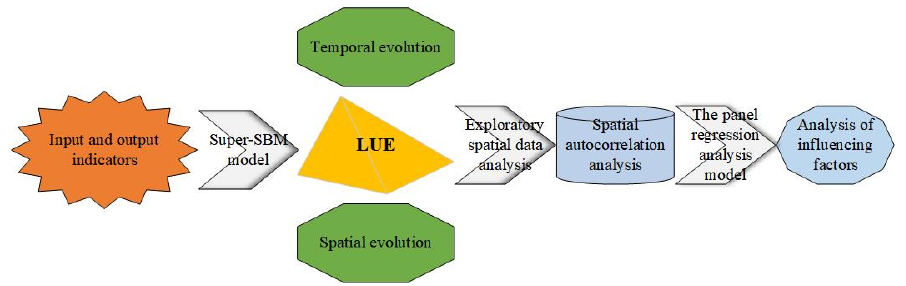
Figure 1. Research